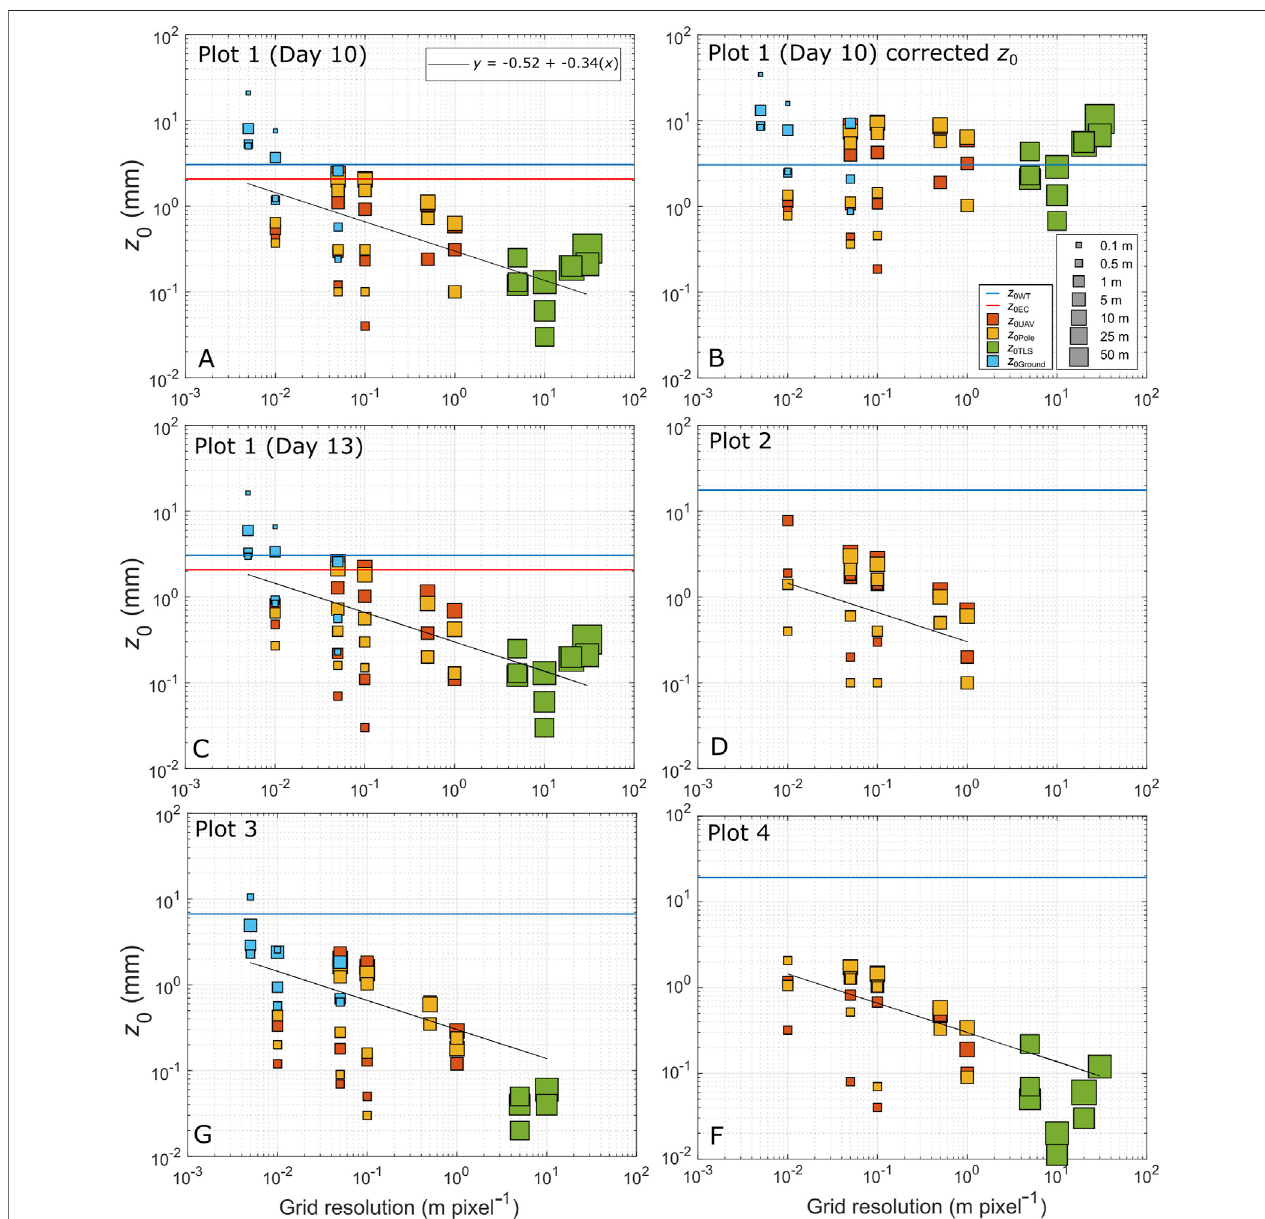
FIGURE 4 | DEM grid resolution against z 0DEM on log-log scale. Each data point represents z 0DEM calculated using particular method, resolution and window size, extractedatthewindtowerlocationwithinthePlot. (A) Plot1Day10uncorrected z 0DEM ,alongwithpowerlawmodeldeveloped usingPlot1Day10data. (B) Corrected z 0DEM forPlot1Day10,wherethecorrectionfactorforeachDEMresolutionisappliedtorawinputdata. (C) Plot1Day13uncorrected z 0DEM withPlot1Day10modelto demonstrate its applicability elsewhere. (D) Plot 2 uncorrected z 0DEM , again with model from Plot 1 Day 10 for illustration. (E) Plot 3 uncorrected z 0DEM . (F) Plot 4 uncorrected z 0DEM . The legends in (A) and (B) apply to all plots. The blue lines show z 0WT for each plot (see Table 4 ) and red line show z 0EC at Plot 1.